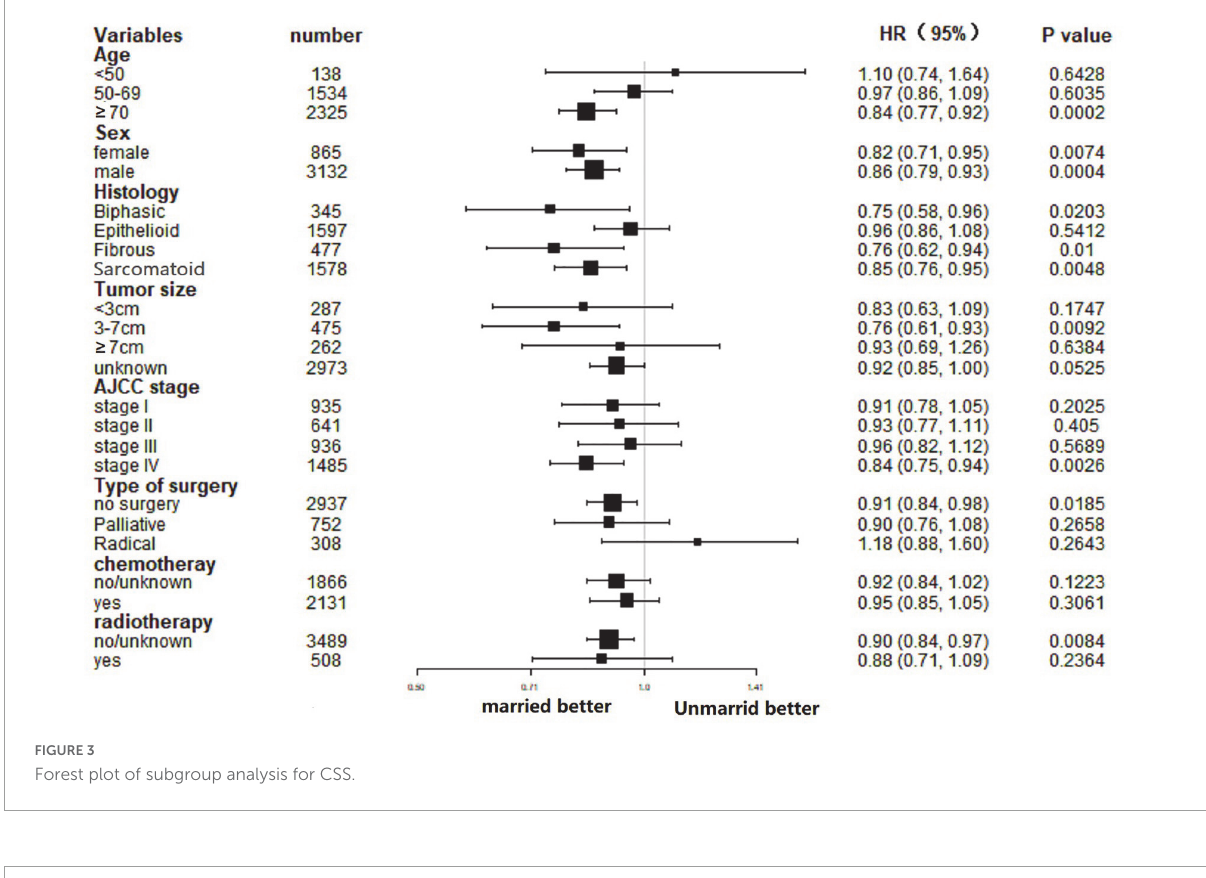
FIGURE3 Forest plot of subgroup analysis for CSS.